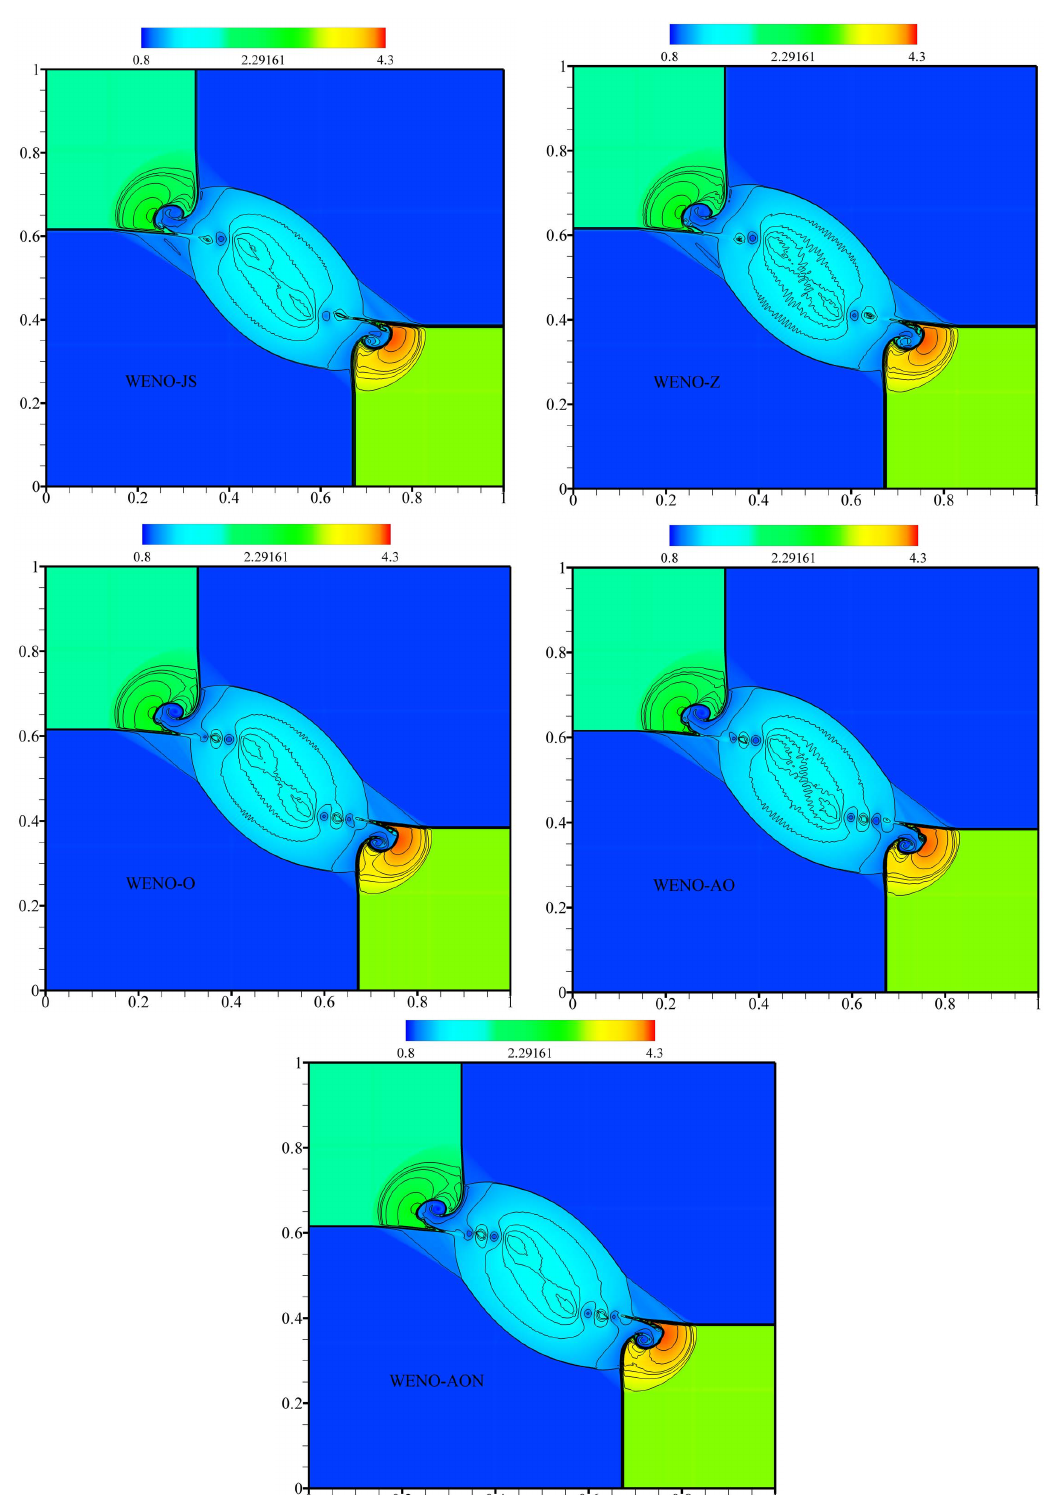
Figure 21. Equally spaced contours of two-dimensional Riemann problem of Example 8 (Section 6.3.2) at time 0.23, CFL = 0.6, [ 0,1 ] × [ 0,1 ] 2-D domain and 800 × 800 mesh